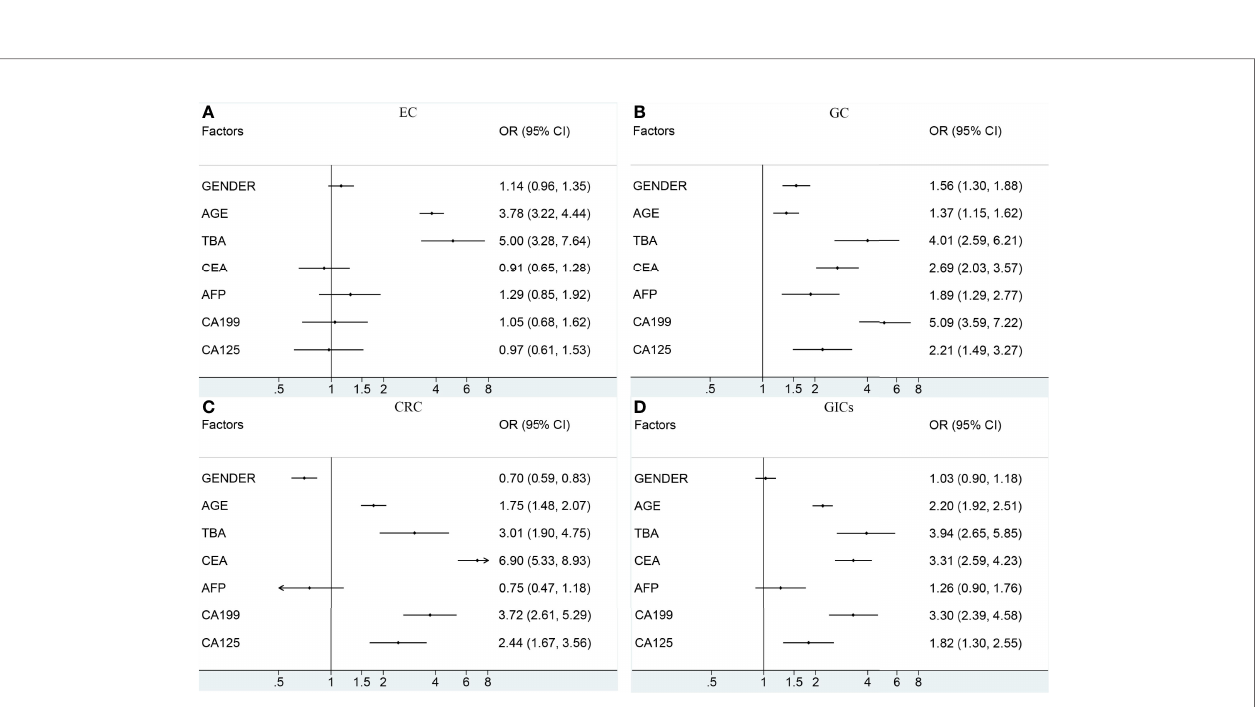
FIGURE 3 | The association between the potential risk factors and the risk of EC (A) , GC (B) , CRC (C) , GIC (D) . The black dot indicates the OR of each category. The horizontal line represents the 95% CI. TBA, total bile acid; EC, esophageal cancer; GC, gastric cancer; CRC, colorectal cancer; GIC, gastrointestinal cancer; OR, odds ratio; CI, con fi dence interval.